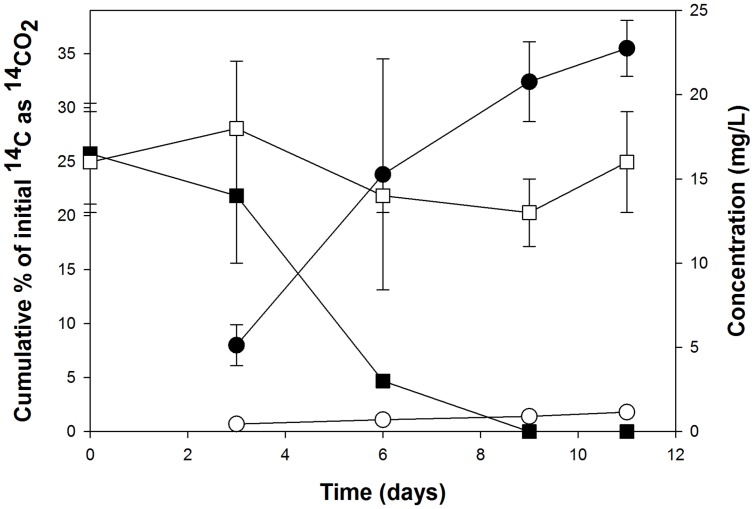
Cumulative 14CO2 recovered from the incubations with 14C-labeled PHE (circles) that were run in parallel to the stable-isotope probing (SIP) incubations, and the respective removal of this polycyclic aromatic hydrocarbon (PAH) in incubations with the corresponding unlabeled substrates as measured by HPLC (squares). Each data point is the mean of results from triplicate flasks ± SD. Filled symbols represent live (uninhibited) cultures; open symbols represent acid-inhibited controls. Some error bars are smaller than the symbol.